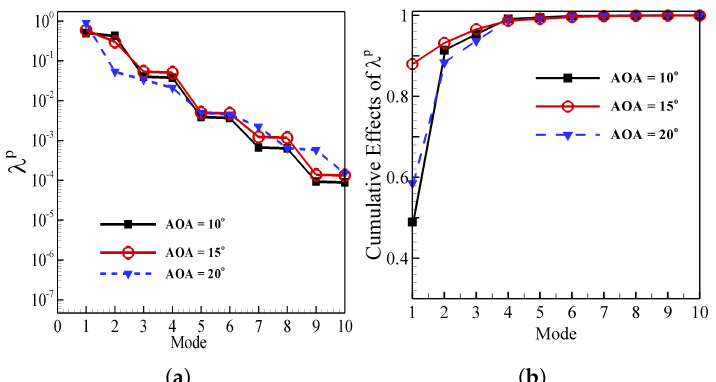
Figure 10. ( a ) Normalized eigenvalues of pressure modes, ( b ) Cumulative effects of pressure eigen- values.